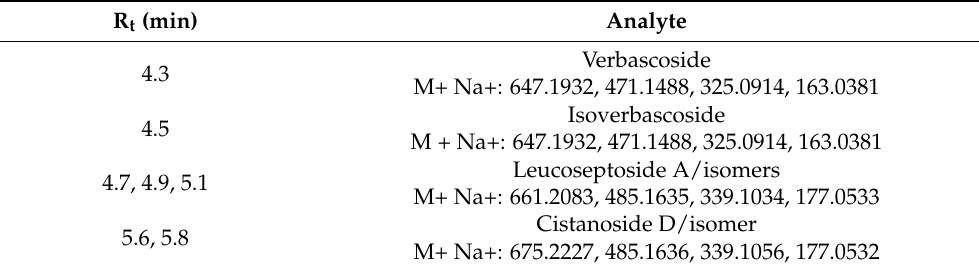
Table 1. Phenylpropanoid glycosides identified by UHPLC-HR-QTOF-MS. R t (min)